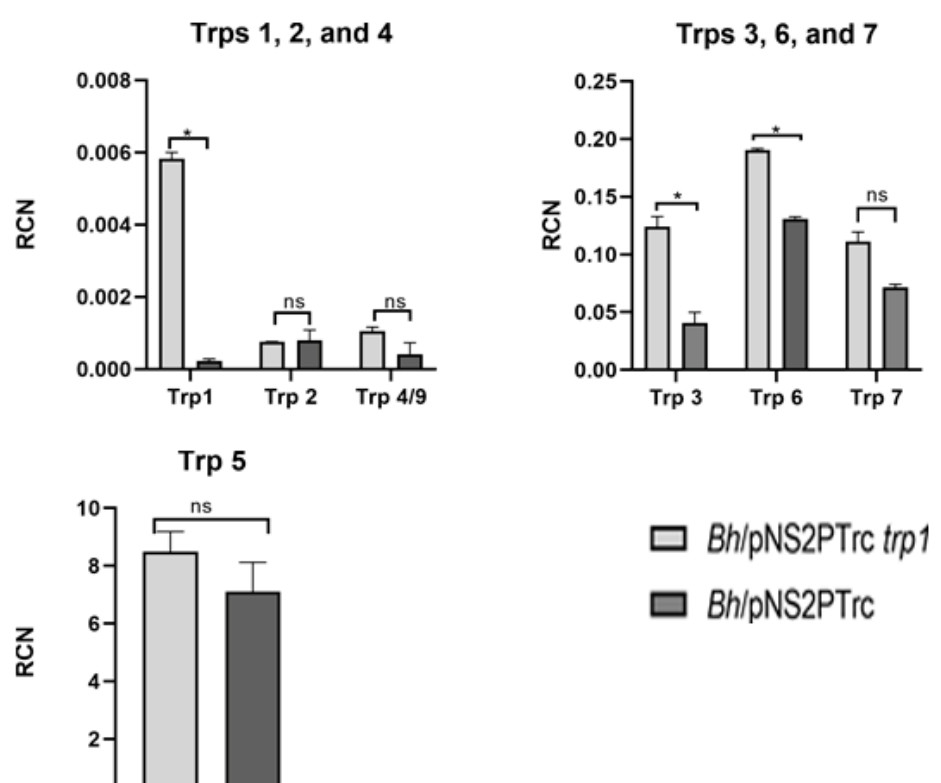
Figure 2. RT-qPCR showing expression of trps in B. henselae Houston-1/pNS2P Trc trp1 (overexpressing trp1 ) with B. henselae Houston-1 pNS2P Trc as control. Upper left : Expression of trps 1, 2, and 4/9. Upper right : Expression of trps 3, 6, and 7. Lower : Expression of trp 5. Relative copy number (RCN) was compared to reference rplD mRNA. Bars represent means of three independent experiments, and error bars represent standard errors. Statistical analysis using Student’s t-test was performed using GraphPad Prism (GraphPad Software, San Diego, CA, USA), (*) with a p -value < 0.05 considered statis- tically significant as indicated.